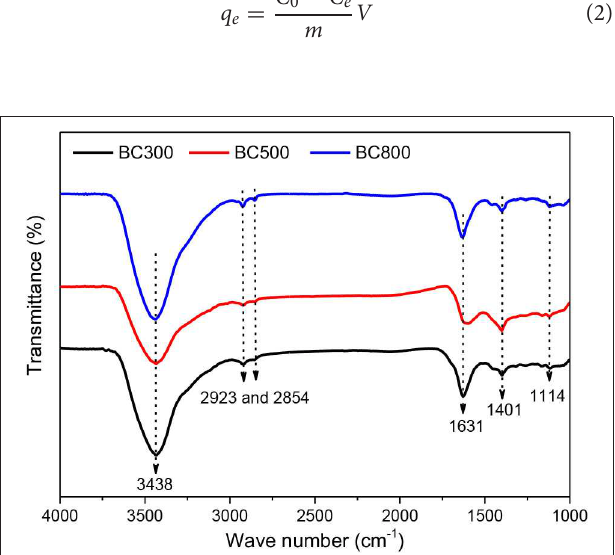
FIGURE 1 | FTIR spectra of biochar samples prepared at 300, 500, and 800 ◦ C. BCXXX stands for biochar prepared at XXX ◦ C; XXX can be 300, 500, and 800.